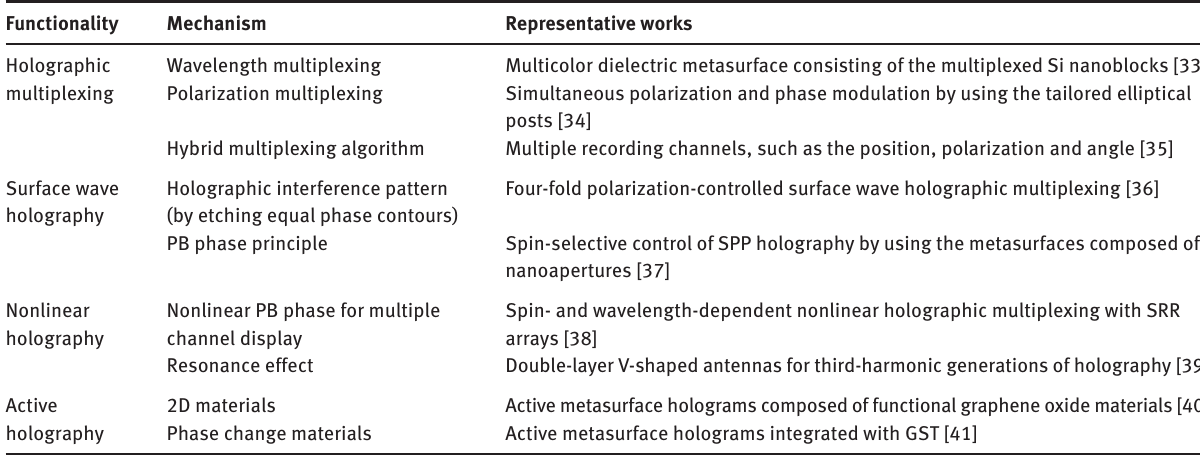
Table 2: Multi-functionalities of the metasurface